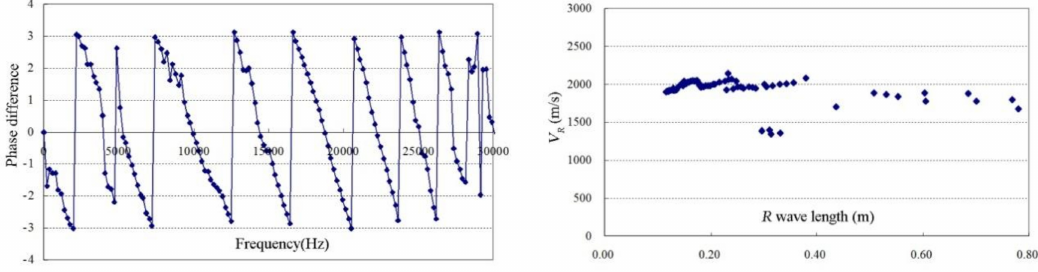
Figure 9. Phase spectrum and dispersion curve of the layered model 3 (concrete-weak